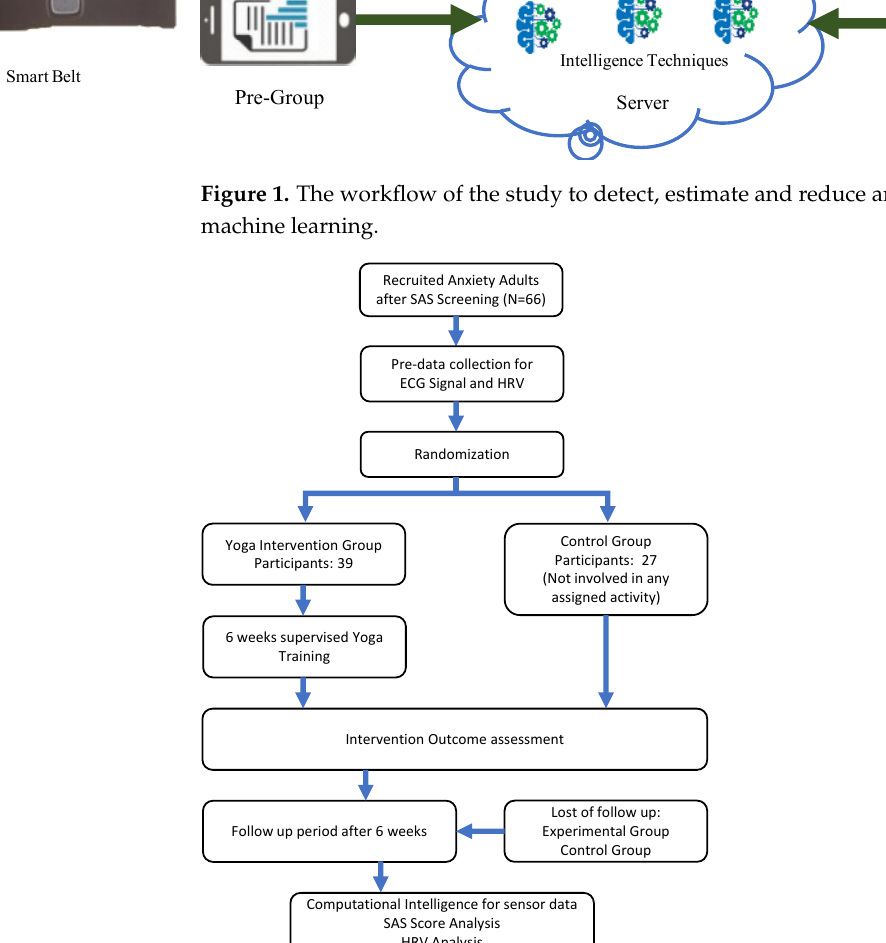
Figure 2. The flowchart for the theranostic approach of the anxiety neurological human behavior using